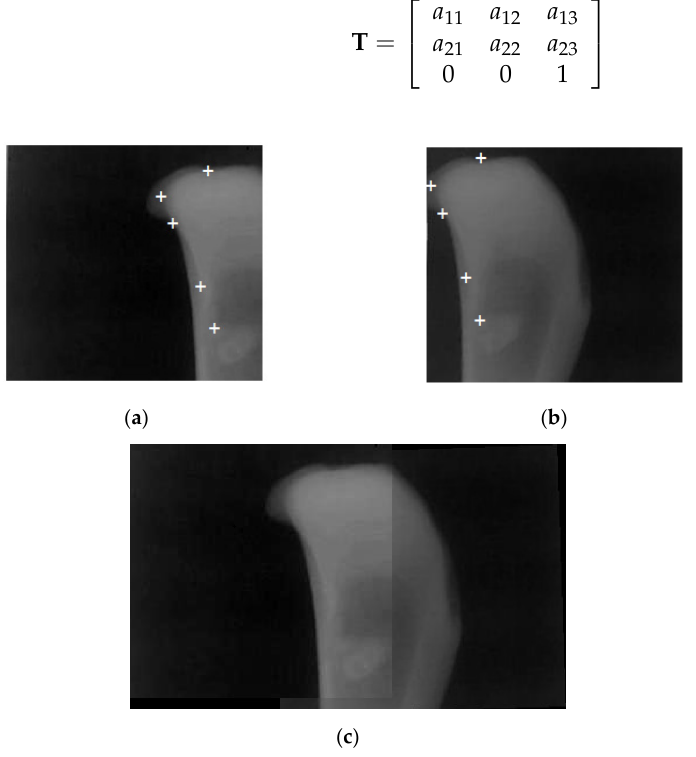
Figure 4. Image registration. ( a ) Image captured from right CMOS sensor; ( b ) image captured from left CMOS sensor; ( c ) aligned image. White crosses are the matched point.